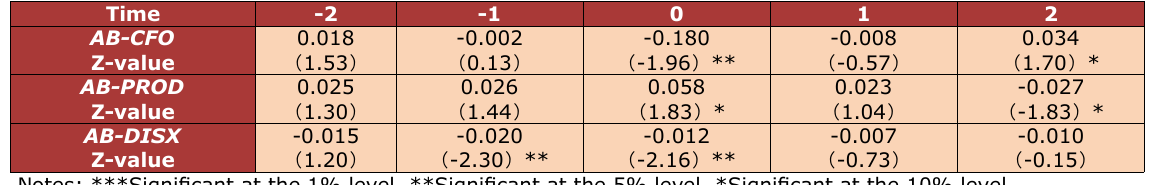
Table 2. Acquiring firm’s real earnings management degree and examining results